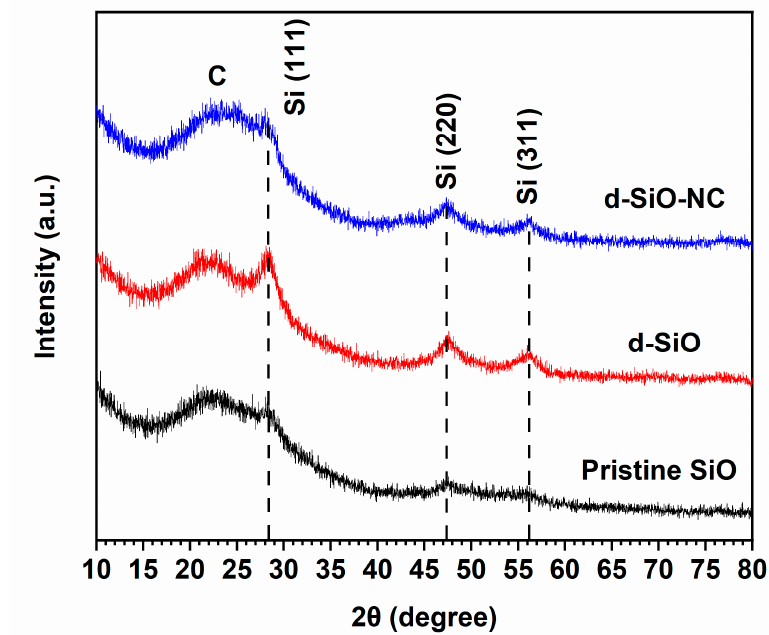
Figure 2. XRD patterns of pristine SiO, d-SiO, and d-SiO-NC (2:1.5:3).